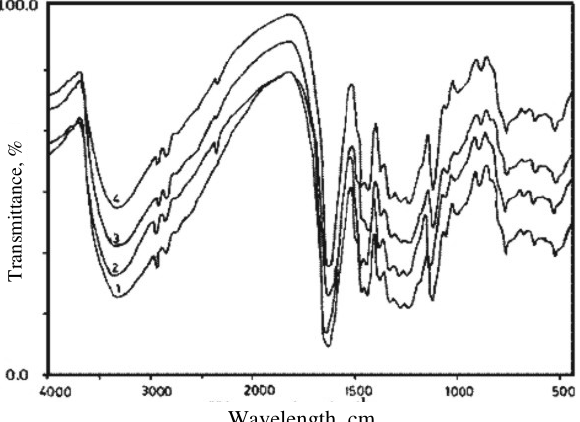
Figure 3 . Infrared spectrum of terpolymer resins (1) 2, 4-DHBOF-I, (2) 2, 4-DHBOF-II, (3) 2, 4-DHBOF-III, 4) 2,